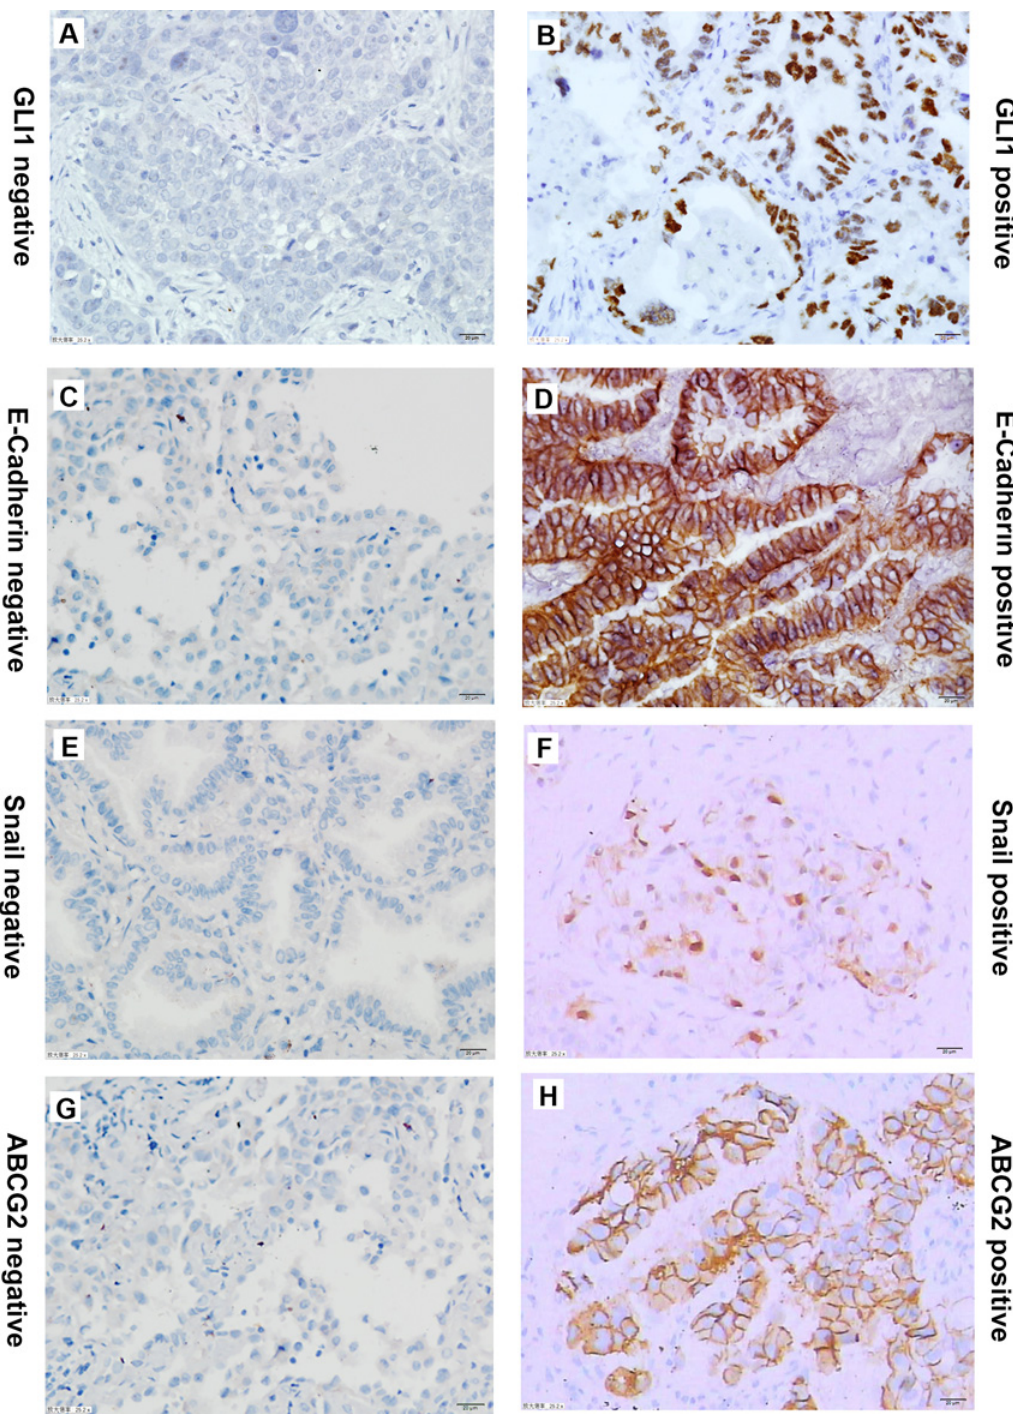
Fig 4. Representative immunostaining of GLI1, ABCG2, E-Cadherin and Snail in NSCLC tissues. (A) and (B), negative control and positive GLI1 expression in NSCLC tissues. (C) and (D), negative control and positive E-Cadherin expression in NSCLC tissues. (E) and (F), negative control and positive Snail expression in NSCLC tissues.(G) and (H), negative and positive ABCG2 expression in NSCLC tissues.